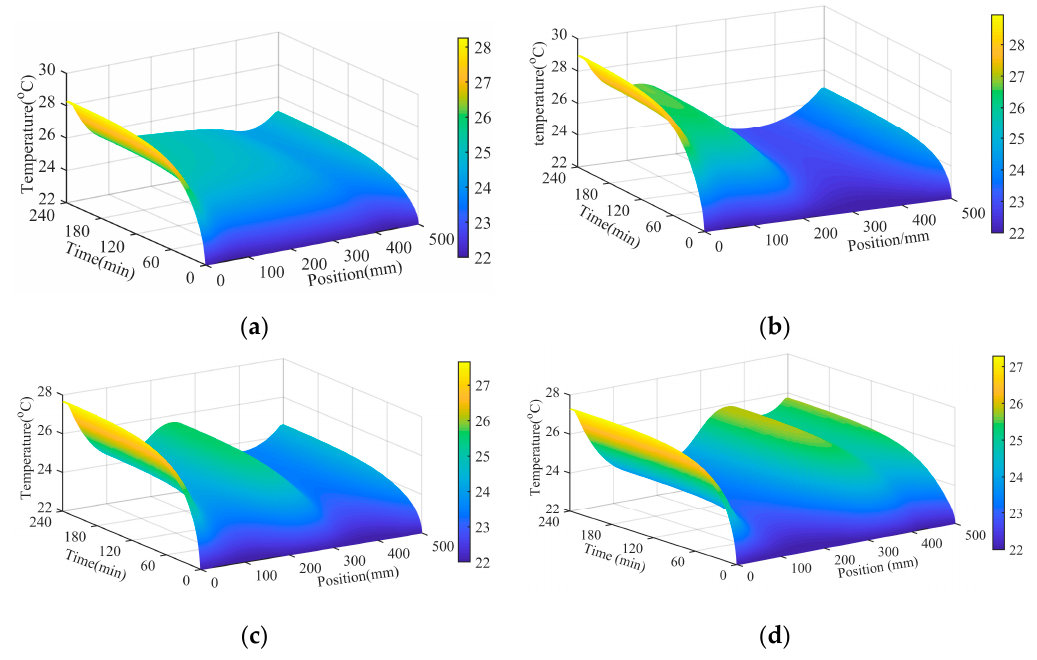
Figure 9. Temperature simulation results of the ball screw feed system under different working conditions: ( a ) working condition 1; ( b ) working condition 2; ( c ) working condition 3; and ( d ) working condition 4.